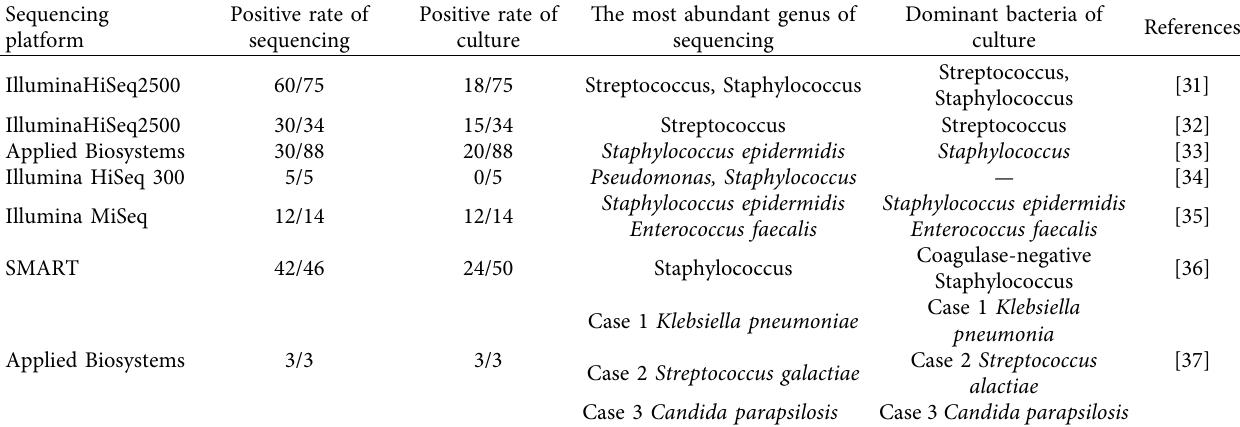
Table 2: Comparison of culture with HTS sequencing